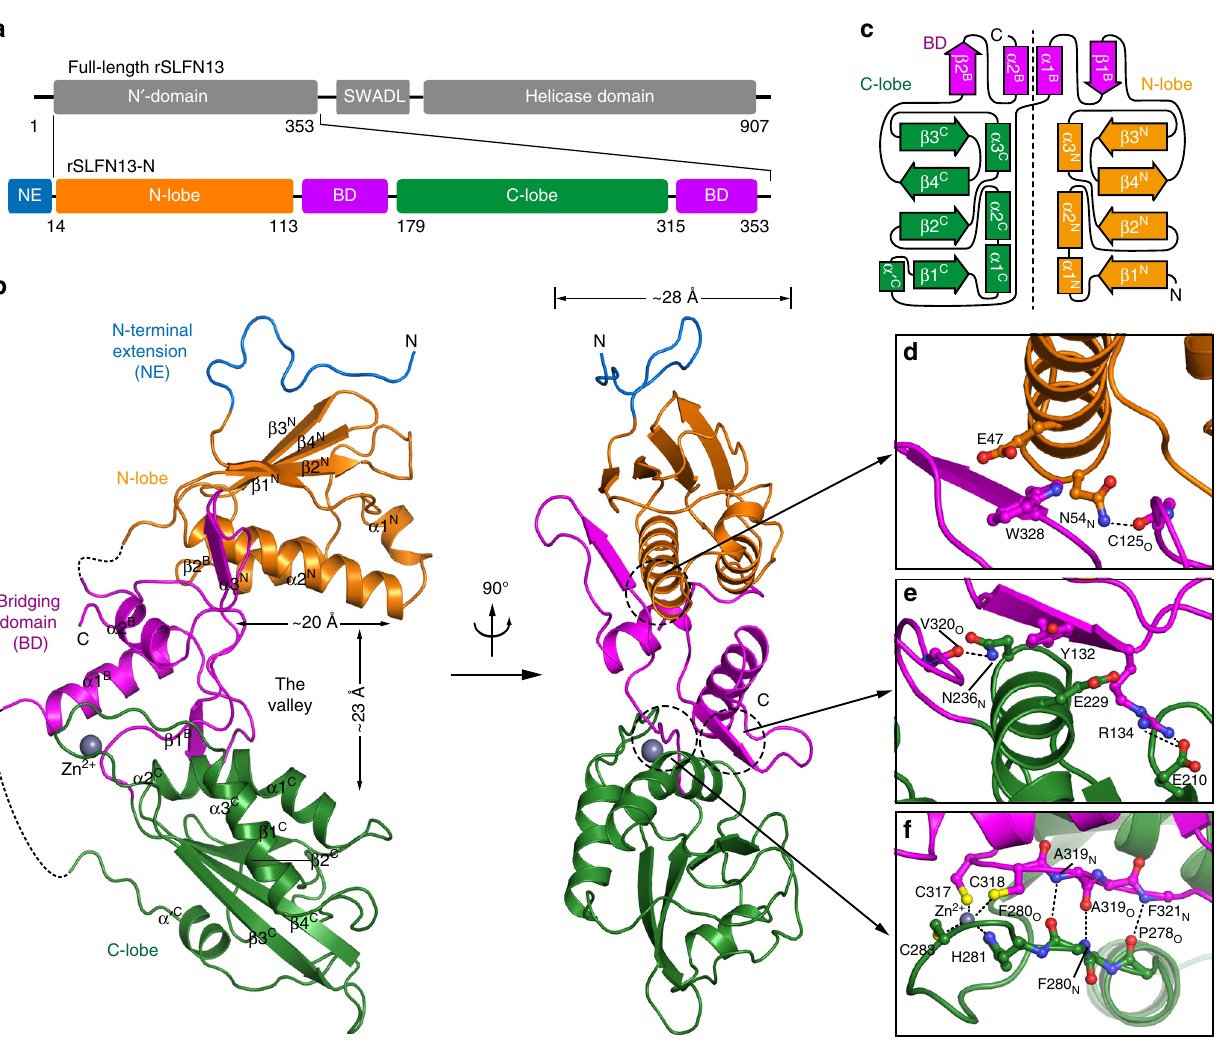
Fig. 1 Structure of rSLFN13 N ′ -domain. a Schematic representation showing the organisation of crystallised rSLFN13 14 – 353 based on full-length rSLFN13. NE denotes the N-terminal extension coded by the DNA sequence from the vector; BD denotes bridging domain. Elements for rSLFN13 14 – 353 are assigned according to the structure. Borders of each element are indicated by residue numbers. b Structure of rSLFN13 14 – 353 . Domains of rSLFN13 14 – 353 are indicated and coloured as in a . Disordered loops are shown as dashed lines. The Zn 2 + ion in the zinc fi nger is shown as a grey sphere. α -helices and β -strands of each domain are speci fi ed. The size of the valley is indicated. c The topology diagram of rSLFN13 14 – 353 . Secondary structural elements were not drawn to scale. Elements of rSLFN13 14 – 353 are named and coloured as in a . A dashed line is drawn to indicate the pseudo-symmetry of rSLFN13 14 – 353 . d Interactions between BD and N-lobe. Side chains of involved residues are shown in the same colour as the domains they belong to. e Interactions between BD and C- lobe. Note the similarity with d . f Extra interactions between BD and C-lobe. Note the CCCH-type zinc fi